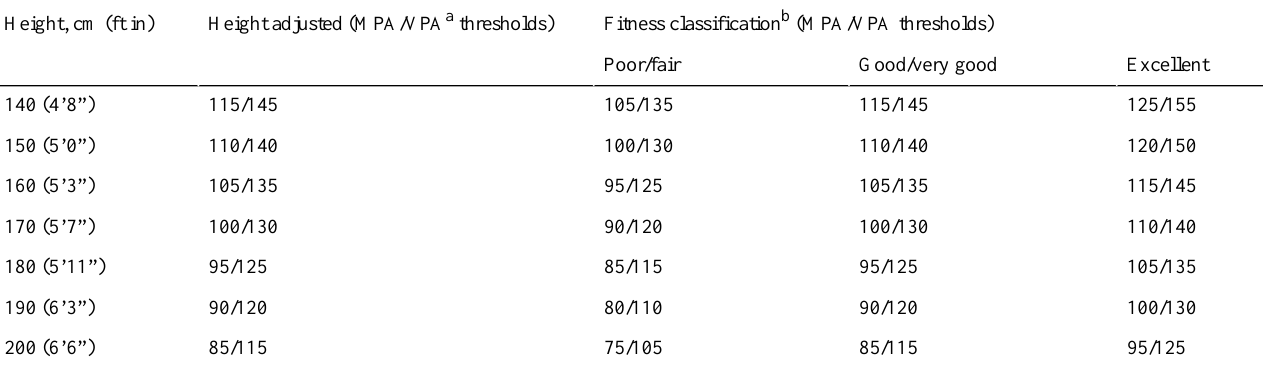
Table 1. Algorithm used to determine the PiezoRx height- and fitness-adjusted moderate-to-vigorous physical activity step rate